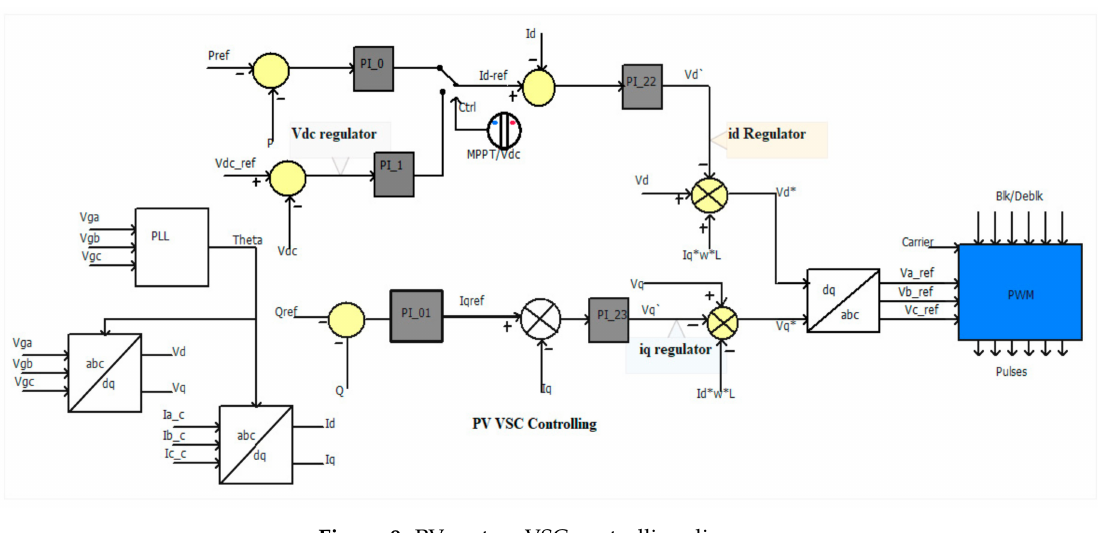
Figure 9. PV system VSC controlling diagram.